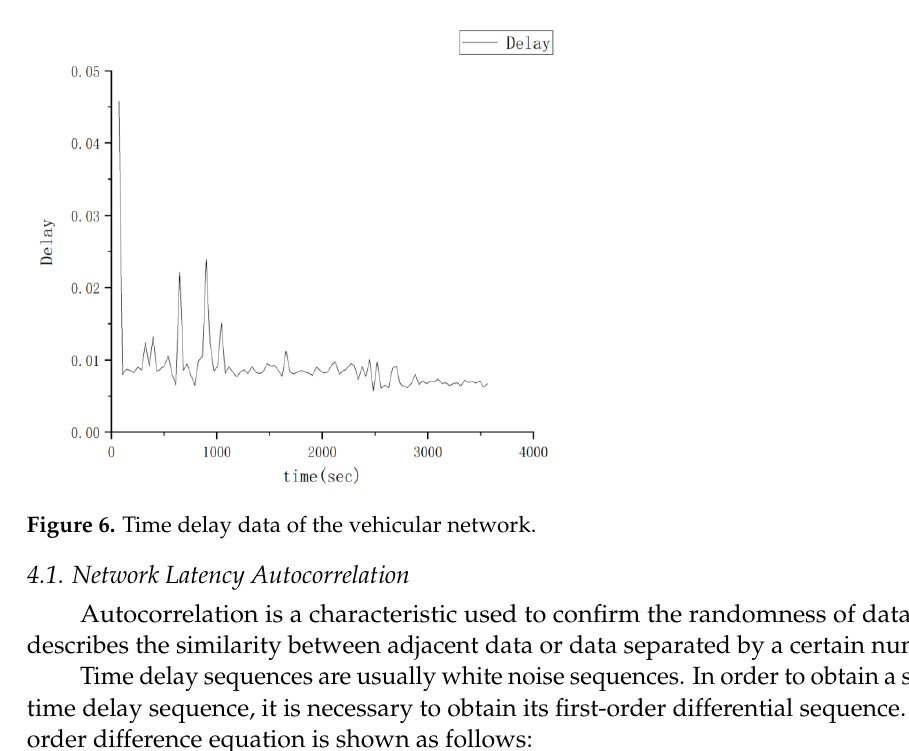
Figure 8. Mean value of first-order difference sequence. The autocorrelation test is conducted by testing the autocorrelation of latency values at different times before and after the network. Considering arbitrary latency sequences Y 1 , Y 2 , ... Y n , assuming that the sequences are stationary, the autocorrelation function r k is estimated for several different latencies k = 1, 2, 3, etc. The time delay sequence is divided into sample sets at k intervals, i.e., the sample correlation coefficients between ( Y 1 , Y 1+ k ), ( Y 2 , Y 2+ k ), ... ( Y n − k , Y n ) . Because of the stationarity, the sequence has constant mean and variance. Therefore, the following sample autocorrelation function r k is established:   =+=